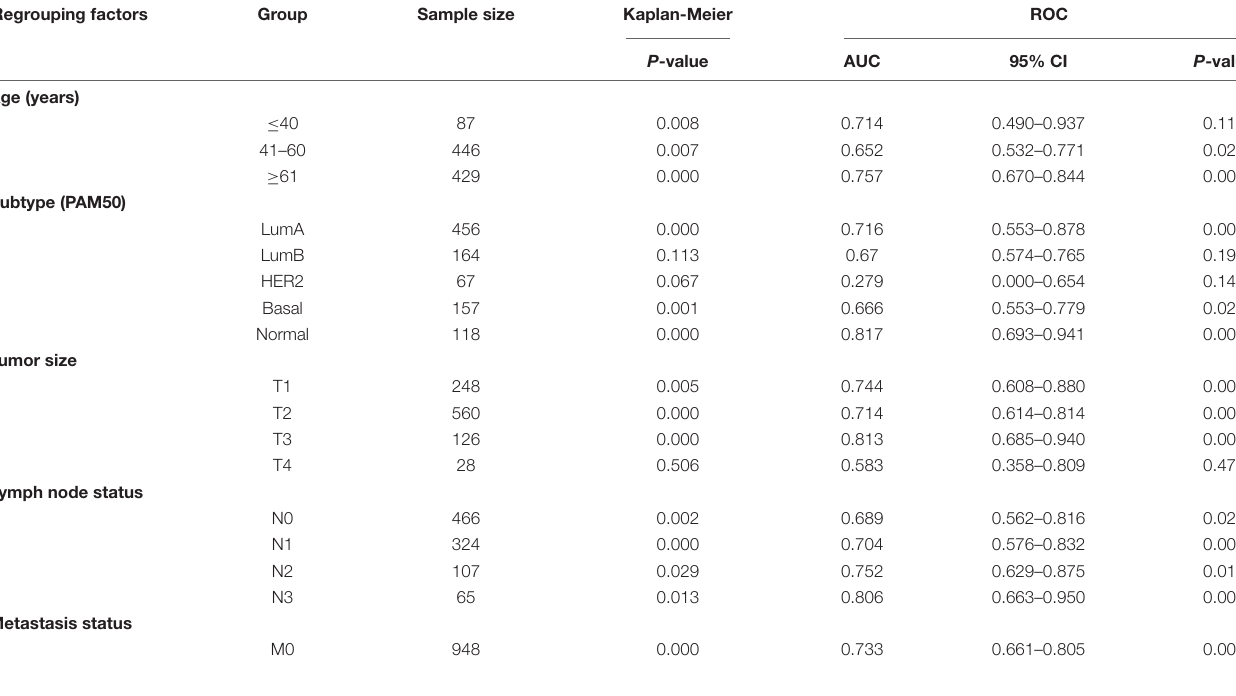
TABLE 6 | Result of Kaplan–Meier and ROC analysis based on different regrouping